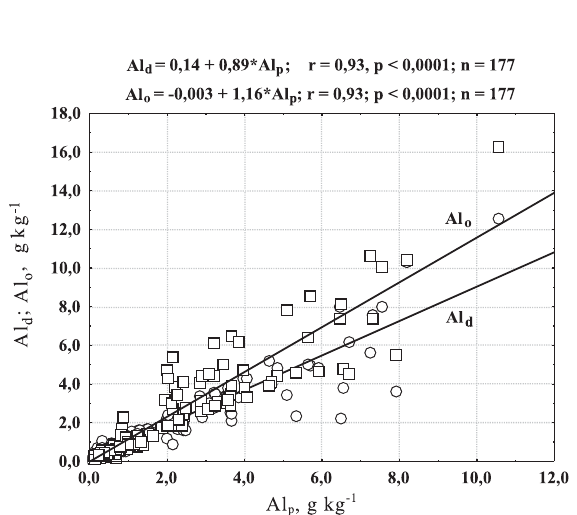
Figura 3. Relação entre o teor de Al extraído com NaOH (Al ) e o de Al extraído por NaOH, mas n não por ditionito (Al -Al ), oxalato (Al -Al ) e n d n o -Al ). Foram incluídos apenas pirofosfato (Al n p horizontes com valores de Al diferentes de zero e aqueles com diferença positiva ou nula entre os extratores.